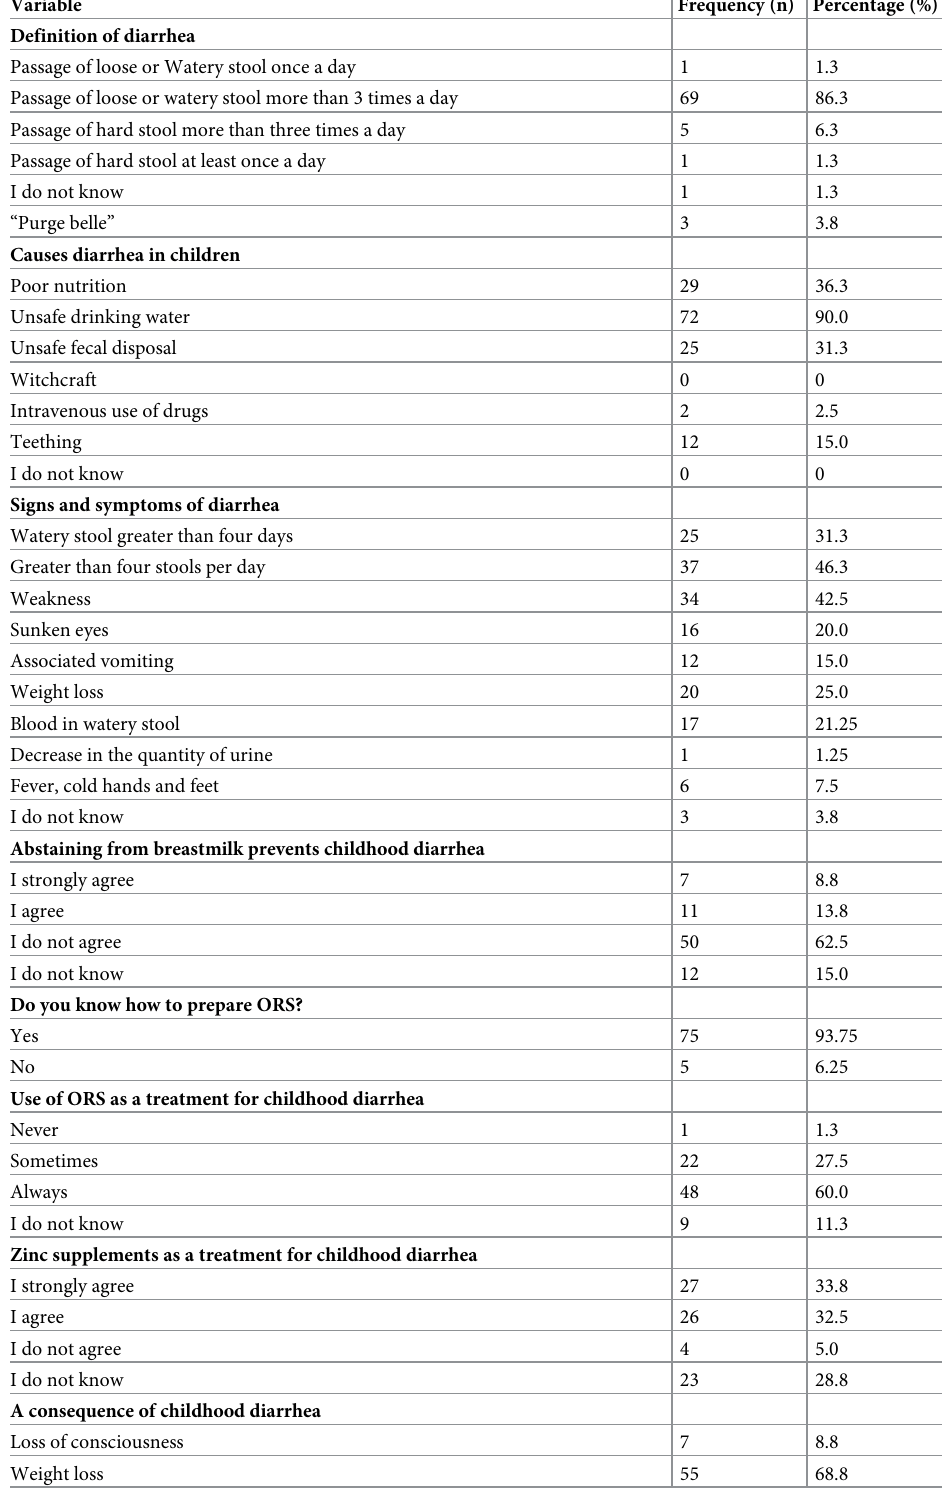
Table 7. CHWs’ knowledge on the management and prevention of childhood